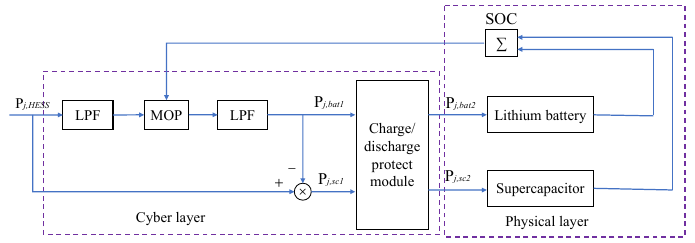
Figure 7. Power allocation scheme.